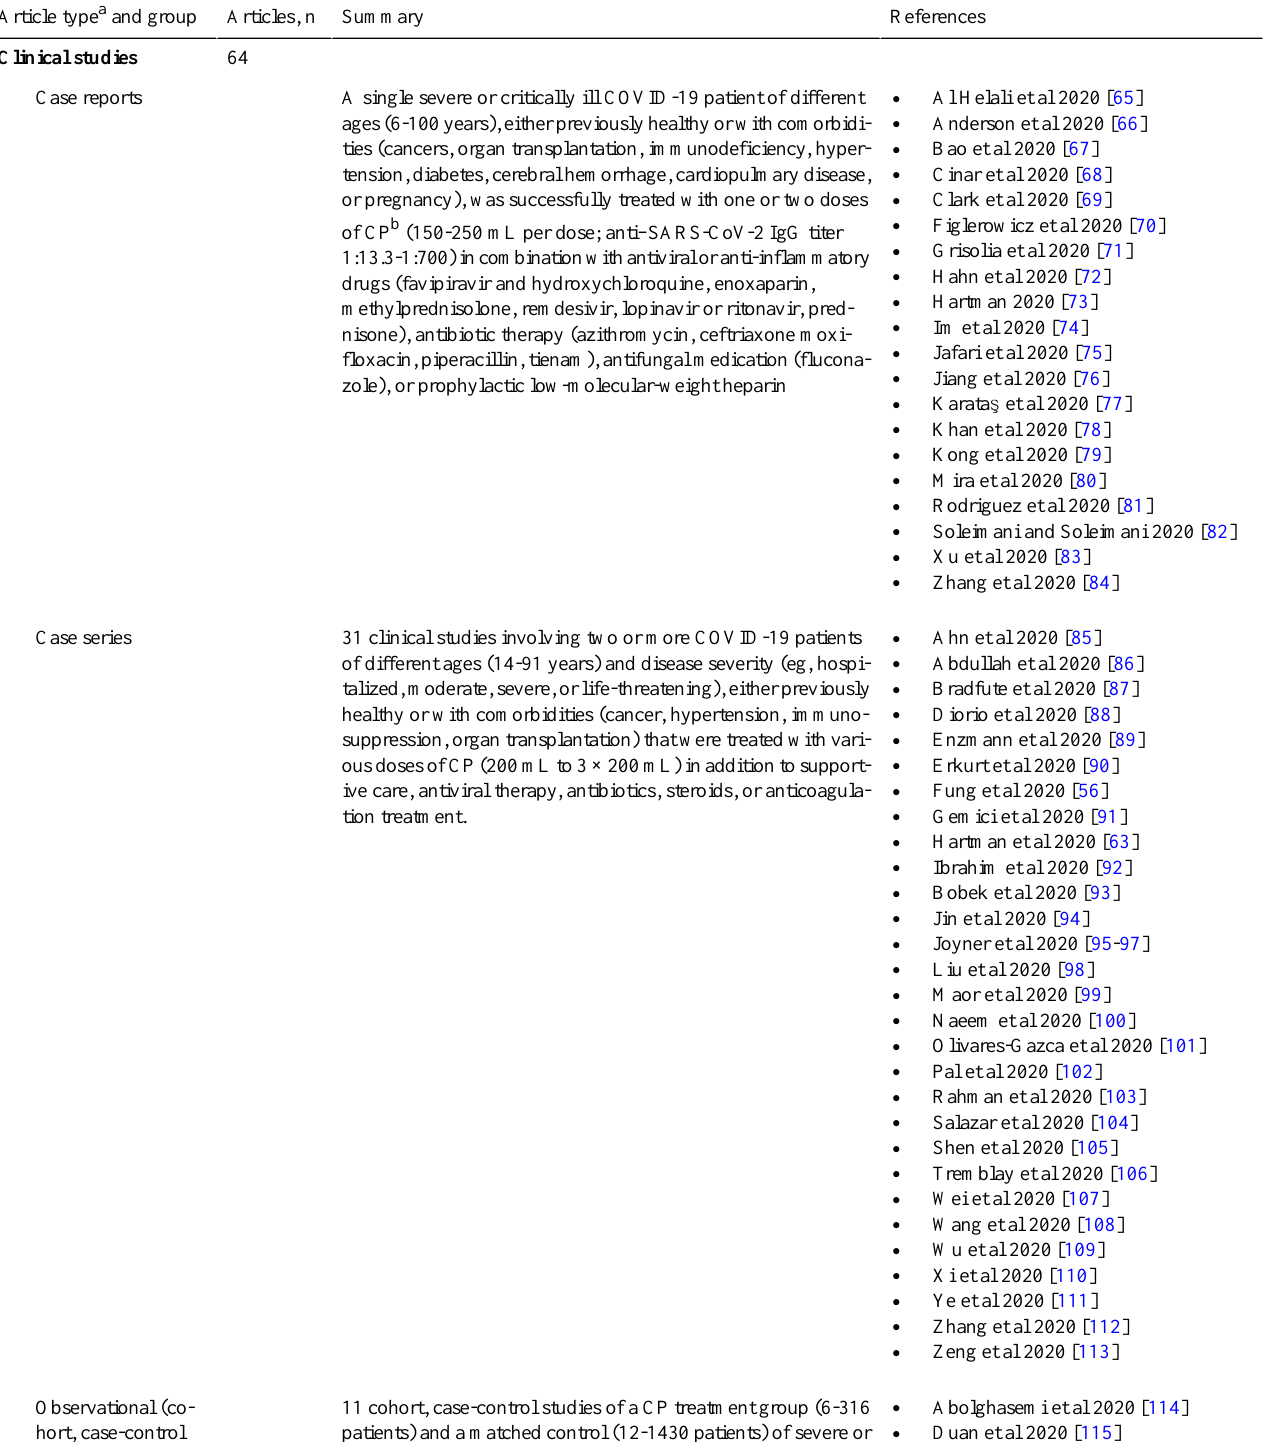
ReferencesSummaryArticles, nArticle type a and